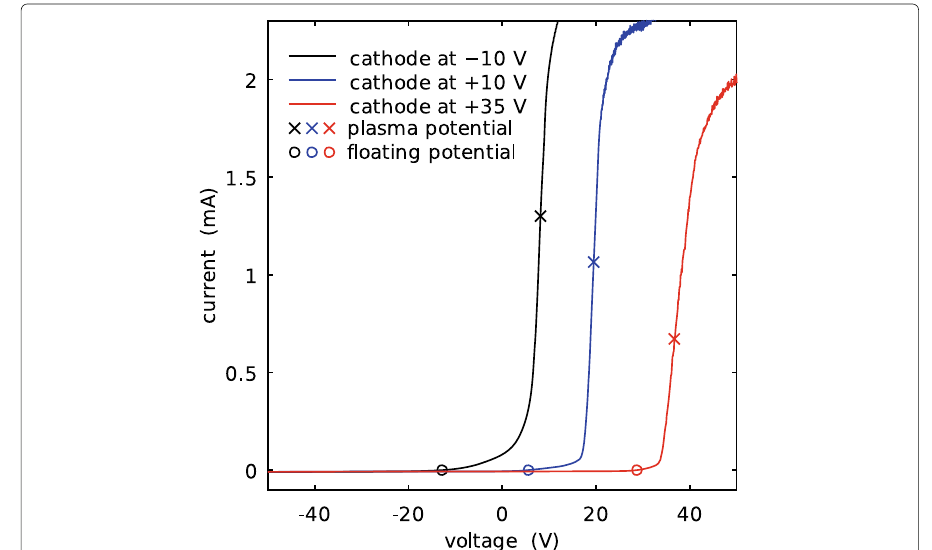
Fig. 8 LP measurements at different plasma potentials in the HIBEX test chamber with the gridded ion source. The plasma potential is manipulated by means of the cathode (hot filament) bias voltage. The indicated plasma potentials at + 8.1V, + 19.5V, and + 36.7V, and the floating potentials at − 12.8V, + 5.6V,